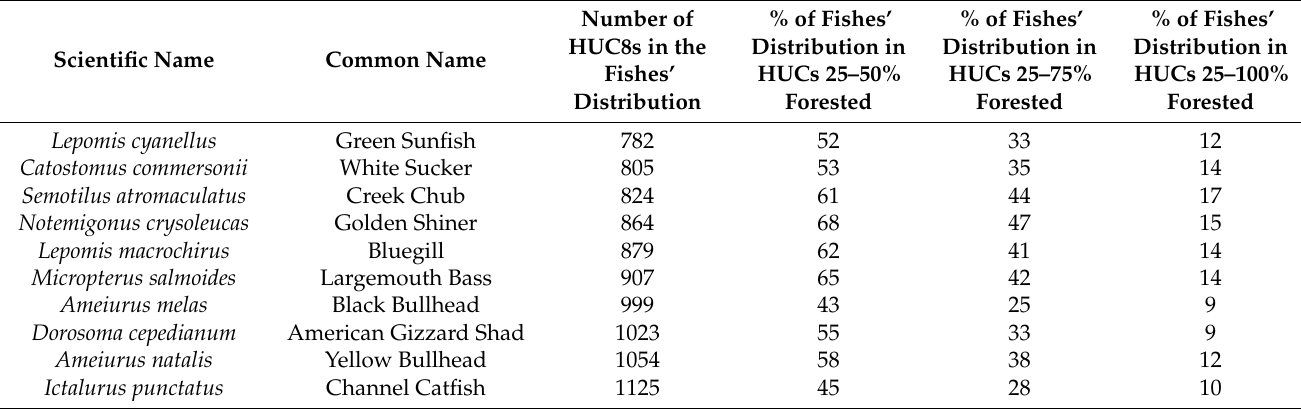
Table 1. The ten species of freshwater fish of the conterminous United States with the largest geographic